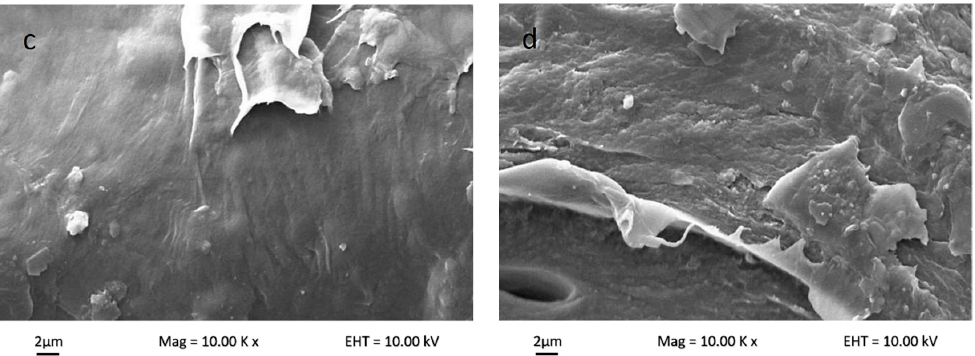
Figure 5. Surface cross-section scanning electron microscopy (SEM) micrographs of ( a ) κ-carr matrix film; ( b ) κ-carr/4% CNC bionanocomposite; ( c ) κ-carr/4% OMMT bionanocomposite; and ( d ) hybrid κ-carr/4% (CNC/OMMT) (1:1) bionanocomposite.